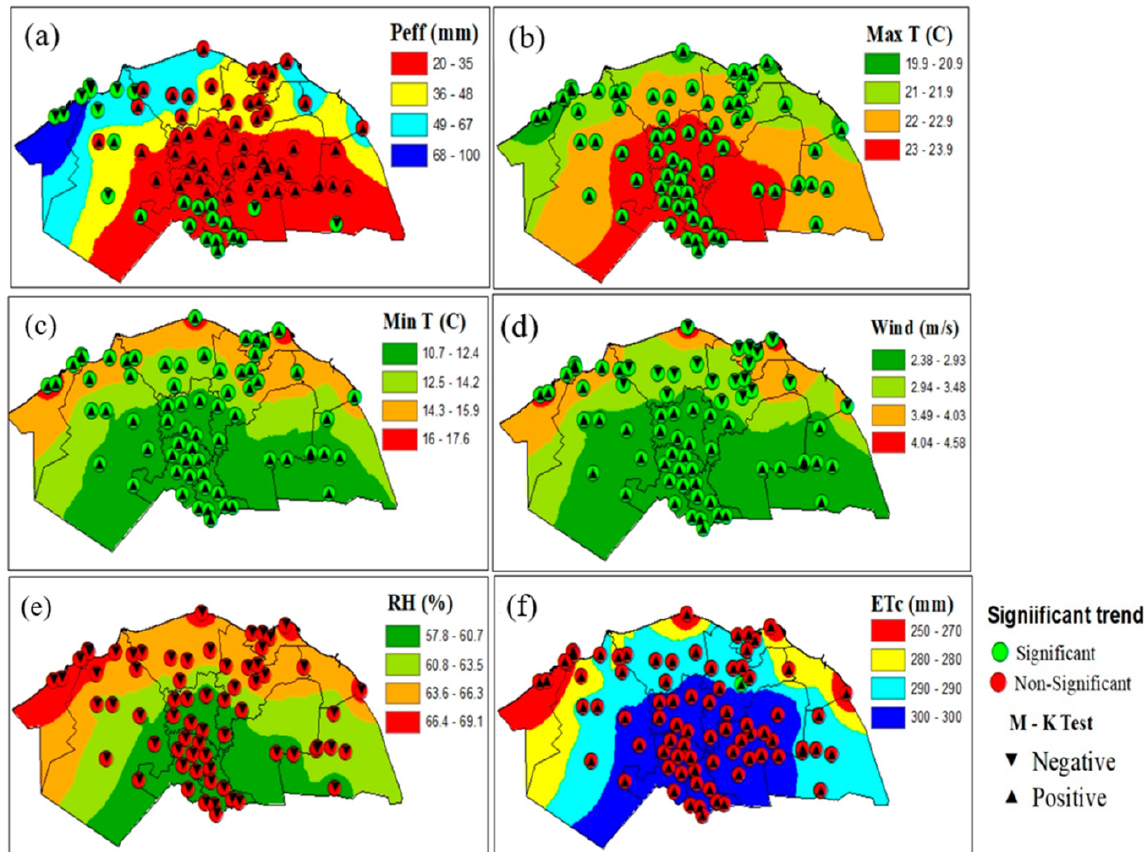
Figure 3. Spatial distribution of “( a )” effective precipitation, “( b )” max. temperatures, “( c )” min. temperature, “( d )” wind speed, “( e )” relative humidity, and “( f )” crop evapotranspiration.